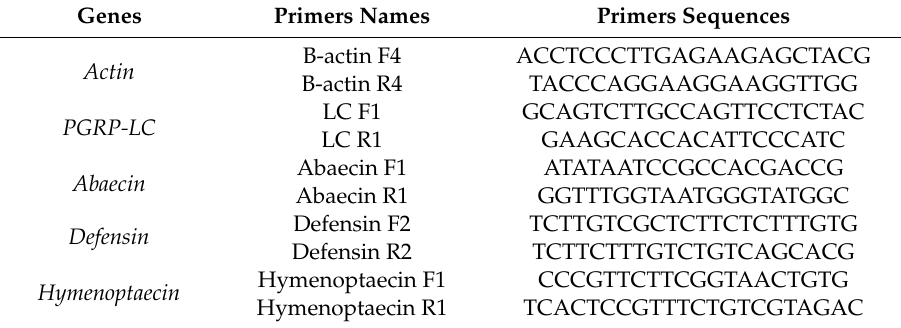
Table 1. Primes of the genes for the real-time qPCR